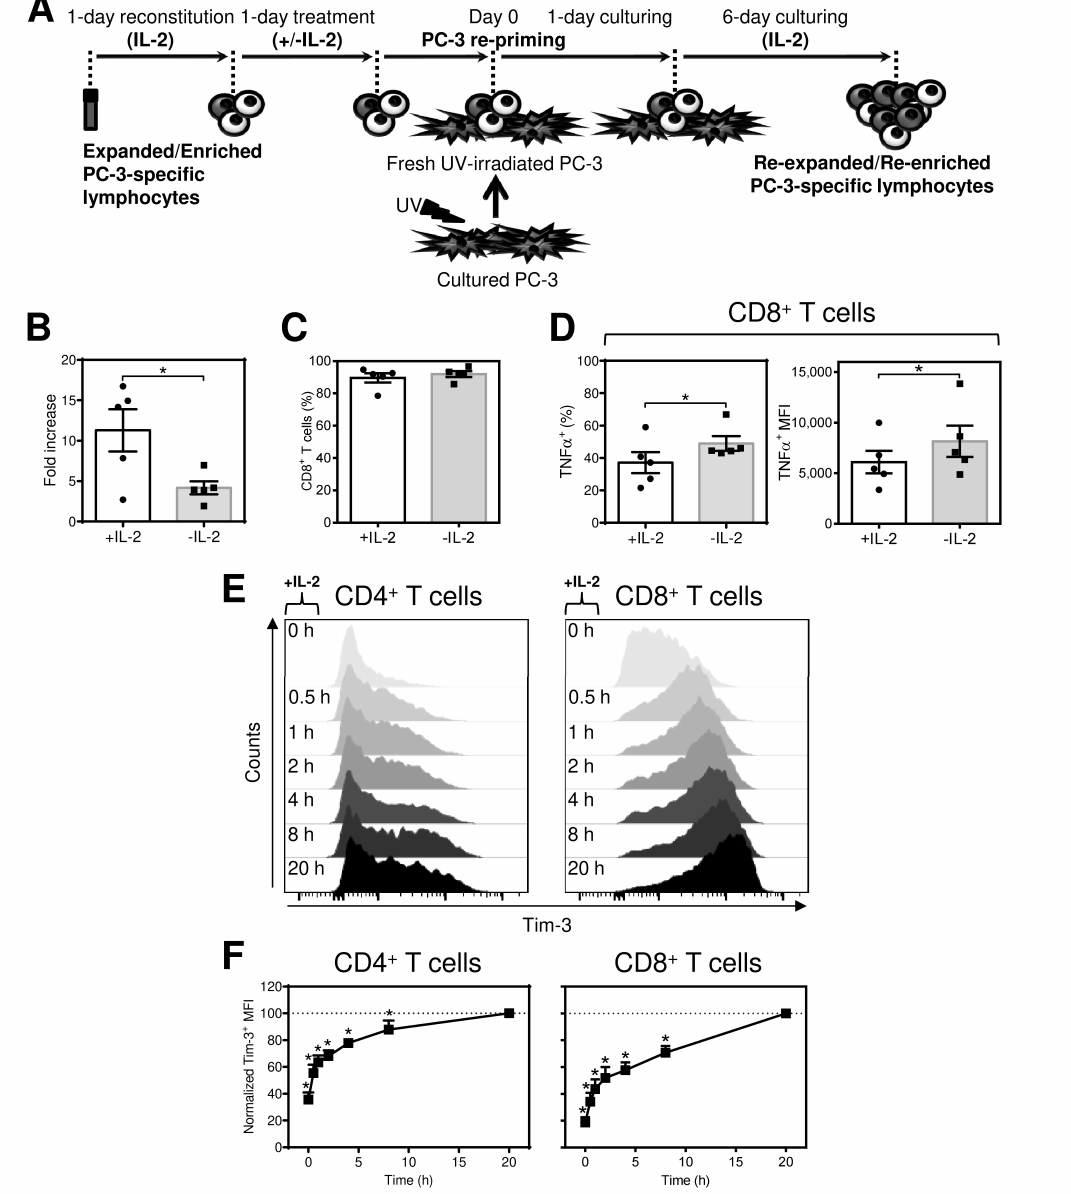
Figure 2. Acute starvation of IL-2 before antigen rechallenge promotes re-expansion of CD8 + T cells with enhanced production of TNF α after antigen stimulation. Acute IL-2 resupplementation enhances surface expression of Tim-3 in antigen-expanded T cells. The 14-day-expanded lymphocytes were reconstituted in the presence or absence of IL-2 and stimulated with UV-irradiated PC-3 cells as in Figure 1. After 18–24 h, the stimulated cells were resuspended and cultured in the presence of IL-2 (2000–4000 IU / mL) for 6 days. The re-expanded lymphocytes were counted, transferred to medium with fresh IL-2 (80 IU / mL) and stimulated with PC-3 cells as in Figure 1. The cells were analyzed by flow cytometry using the gating strategy in Figure 1B. ( A ) Schematic of lymphocyte re-expansion. ( B ) The cell number fold increase of the 7-day re-expanded lymphocytes. ( C ) The proportion of the CD8 + population of T cells in the re-expanded culture. ( D ) The proportion of the TNF α + population (left panel) and its intensity of staining (MFI) (right panel) of CD8 + T cells. ( E , F ) The 14-day-expanded lymphocytes were reconstituted in the absence of IL-2. After 18–24 h, the starved cells were washed and resuspended in fresh LM medium with IL-2 (80 IU / mL). Intensities of Tim-3 staining (MFIs) of CD4 + T cells and CD8 + T cells after IL-2 resuplementation were determined at indicated time points ( E ) and evaluated ( F ). In ( B – D ), bars or data points represent the mean of values determined in each group, and the significance of di ff erences between the group of cells with ( + ) or without ( − ) IL-2 is indicated (* p < 0.05, n = 5 donors, paired 2-tailed Student’s t test). In ( E ), data points represent the mean of values determined in each group, and the significance of di ff erences between MFIs at 0 h and di ff erent time point is indicated (* p < 0.05, n = 3 donors, paired 2-tailed Student’s t